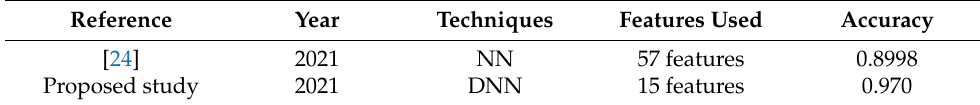
Table 8. Comparison of proposed model with the baseline